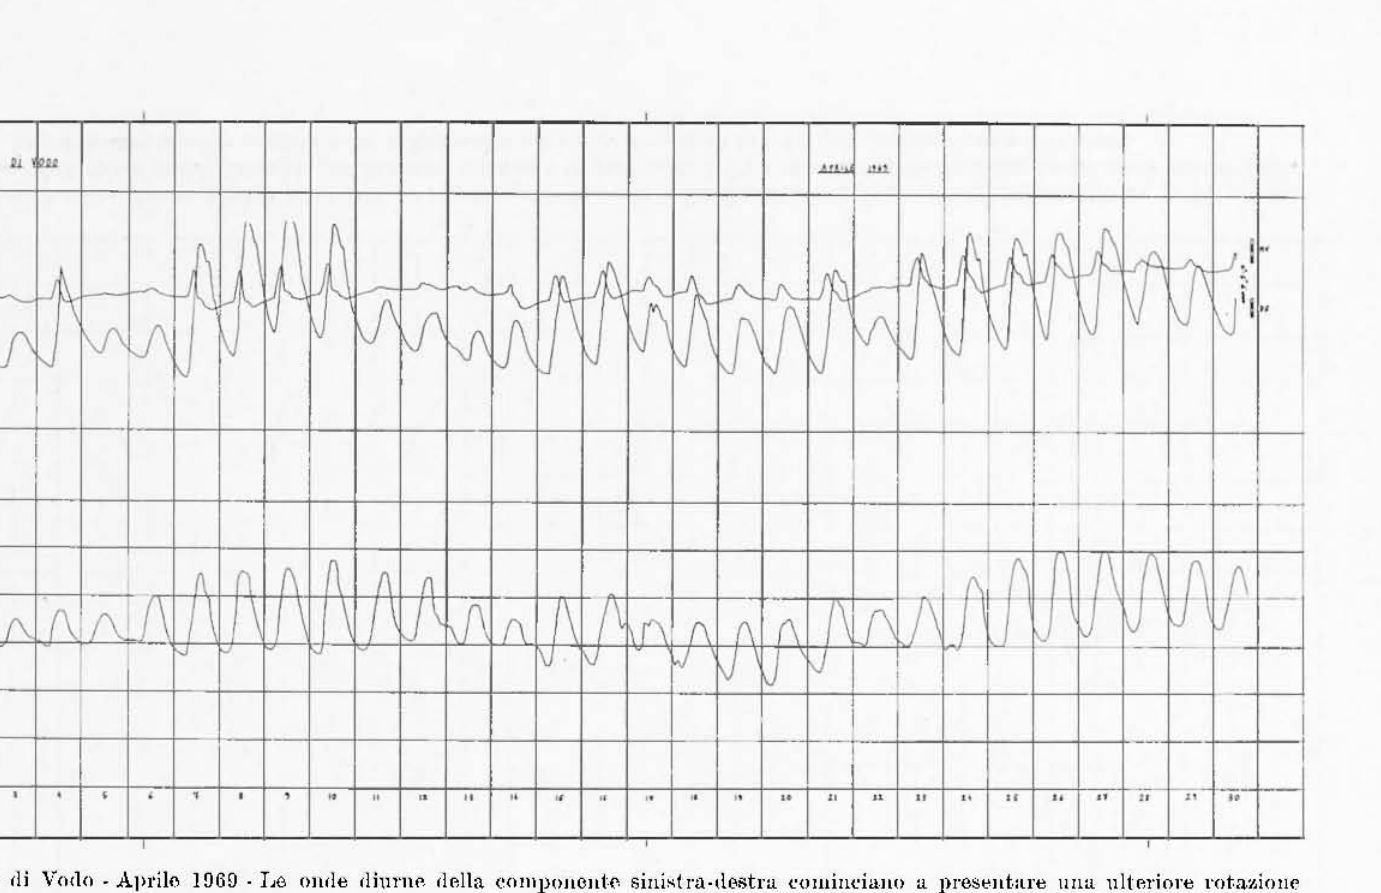
Fig. 6 - Diga di VOl1o . Aprile 1!J6D . Le oJl(le dinr1w dlòlla ('ompOJlCllt(\ sinis(r[\-(!8stra cOlllindallo a prest'lltare Ulla ulteriore rotazionI' a sinistra nelle prime ore ,Ii diminuzione tl'Tllliea; l'illiziale variaziouc dell'illelinazioue a ,["stra P Viep]liù :wcentuata rispetto u. ,[,!ella dol mese pre.e811ellte. Il \'er~() ,Iella risp(lsta a lUllga ,1urata, nella COlll]lolwnte ~illislTa·,le.~tra, IlOIl (, legato ill Ill()(lo lI11h-oeo alle variazioni ,Iella t!'lllperatnra